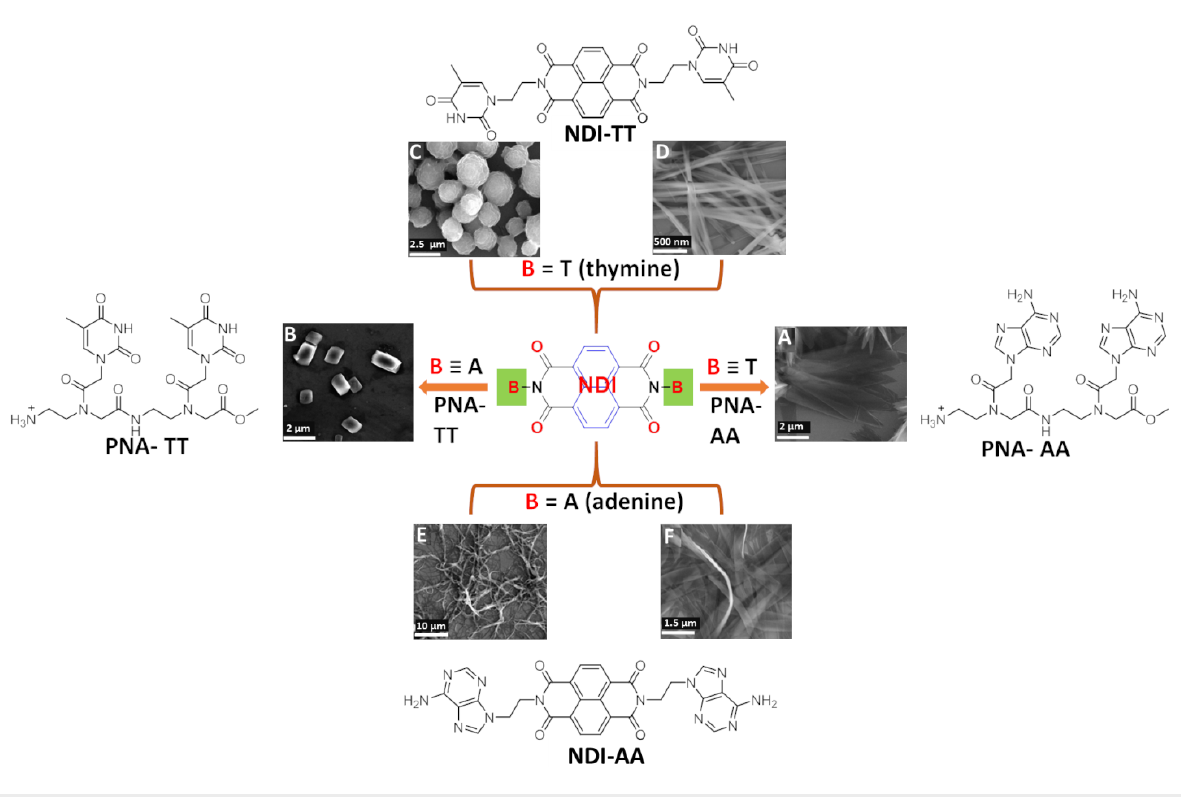
Figure 6: Molecular structures of nucleobase-tethered NDI molecules (NDI-AA and NDI-TT) and their assembly, coassembly, and templated coassembly with PNA clamps. Adapted with permission from [75], copyright 2013 Royal Society of Chemistry.